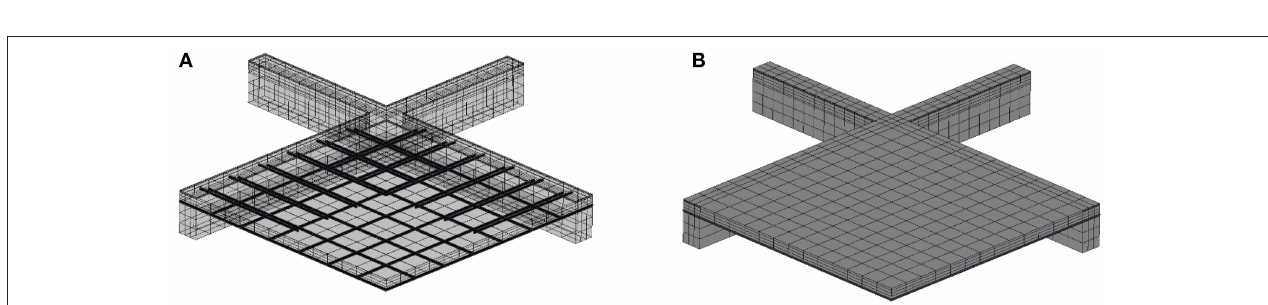
Flexural moments in the circular geometry was computed from a slab modeled with quadrilateral plate elements, avoiding triangular elements at the center of the model, which could generate numerical instability for the large element aspect ratio. According to Figure 7A , negative moments occurred from the edge to the dotted line, in an external ring with an approximated